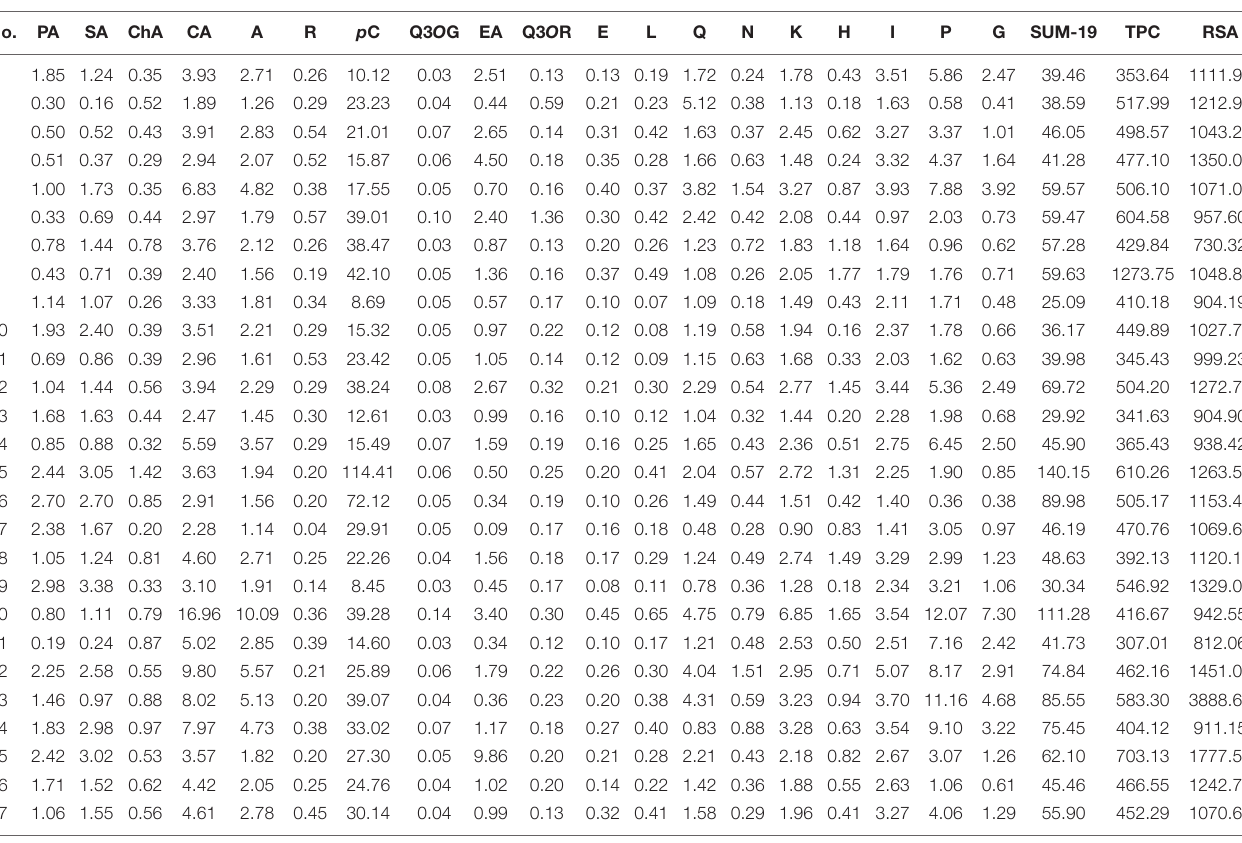
TABLE 5 | Content of the 19 phenolic compounds (mg/kg), sum of the content of all 19 phenolic compounds (SUM-19; mg/kg), TPC (mg GAE/kg), and RSA ( µ mol TE/kg) in the analyzed honey samples (monofloral Nos. 2, 13, 17, and 21; polyfloral and honeydew honey Nos. 16, 20, 22, 23, and 25) from the Tara Mountain region in